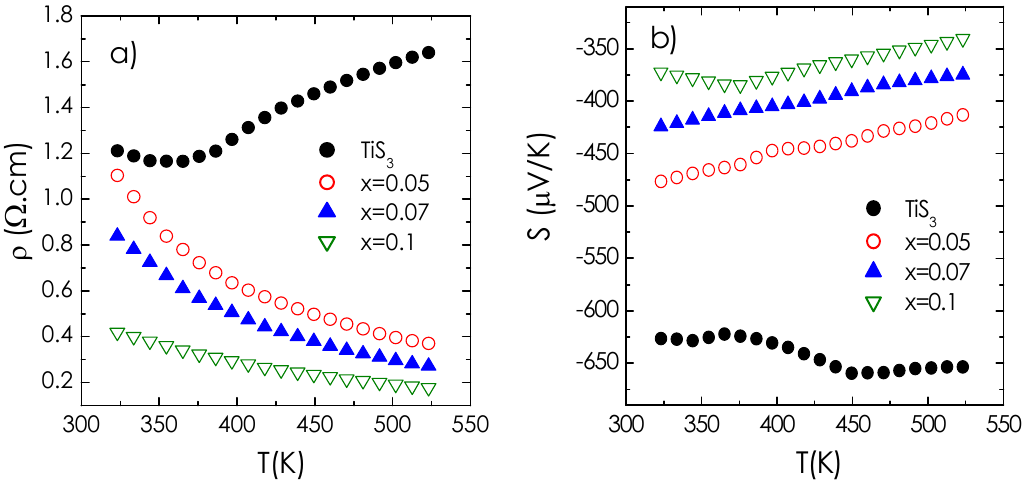
Figure 4. Temperature dependence of ( a ) electrical resistivity and ( b ) Seebeck coefficient in the Ti 1 – x Nb x S 3 series.